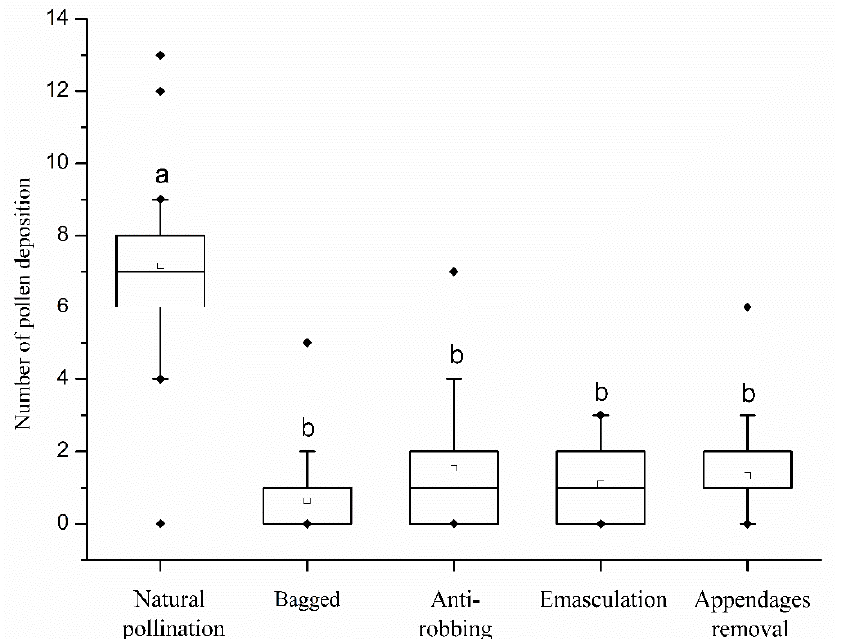
Figure 8. Comparison of pollen deposition number between different treatments. Boxplots show medians, quartiles, interquartile ranges and outliers. Different letters on items indicate significant difference at the 0.05 level.